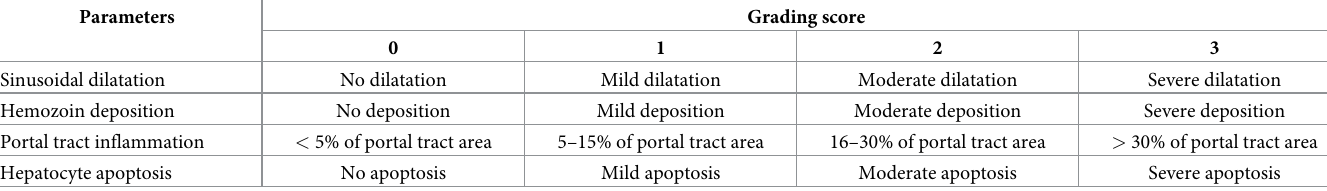
Table 1. Grading system for four main histological features to assess the severity of liver injury.